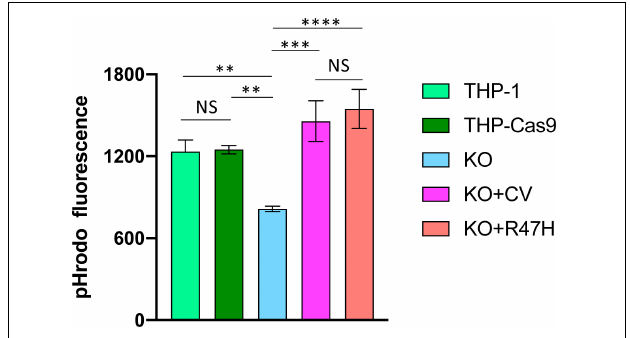
FIGURE 6 | Phagocytosis of aggregated pHrodo-labeled amyloid beta-peptide. THP-1, unmodified cells; THP-Cas9, THP1 stably expressing Cas9 nuclease; KO, TREM2 knockout; KO + CV, KO + R47H, KO expressing common variant (CV) or R47H TREM2, respectively. All cells were treated with doxycycline, then incubated with pHrodo-labeled A β . Data are shown as mean of biological triplicates ± SD (NS, non-significant; ∗∗ p < 0.01; ∗∗∗ p < 0.001; and ∗∗∗∗ p < 0.0001, one-way ANOVA, Tukey’s multiple